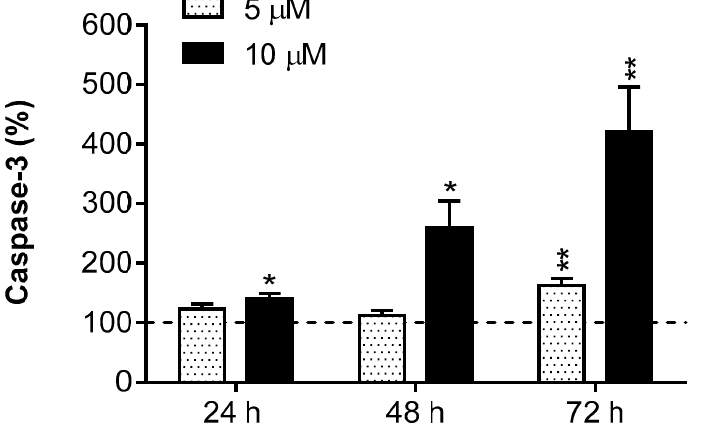
Figure 6. Effect of R2-viniferin on caspase-3 activity in HepG2. Cells were incubated with R2-viniferin (5 µM and 10 µM) at the indicated times. Results are expressed as the percentage (%) of the control values, and are the mean ± SE of 4 experiments. * p < 0.05, ** p < 0.01, compared with controls. We then analyzed by the effect of R2-viniferin on the apoptosis-related Bcl-2 protein family. The resveratrol oligomer upregulated the expression of the proapoptotic Bax protein and downregulated anti-apoptotic Bcl-2 proteins (Figure 7). The Bax/Bcl-2 ratio increased dose-dependently (39% and 123%) over control at 5 µM and 10 µM, respectively.